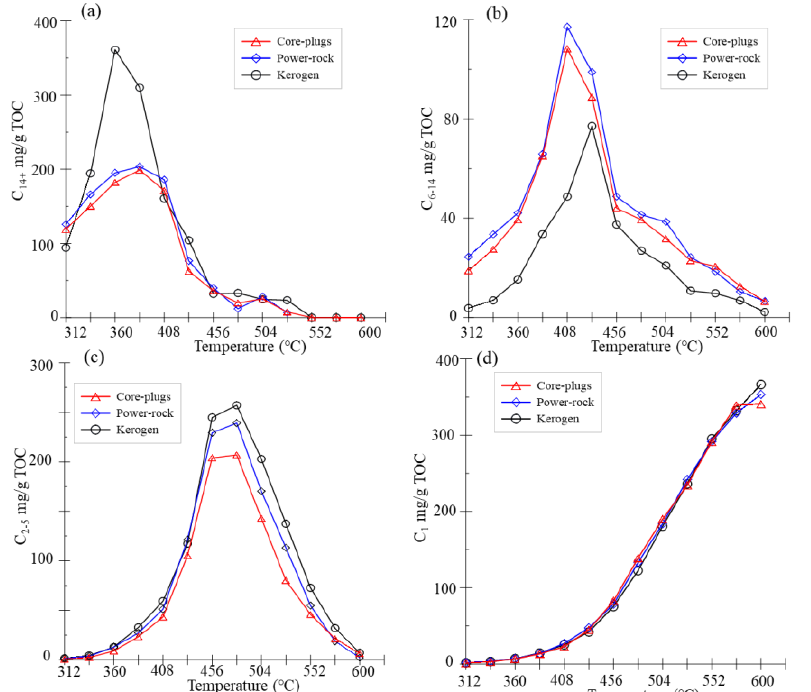
Figure 4. Hydrocarbon yield generated from pyrolysis of core plugs, powdered rock and kerogen of Maoming oil shale. ( a ) Heavy hydrocarbons (C 14+ ); ( b ) light hydrocarbons (C 6-14 ); ( c ) wet gas (∑C 2- 5 ); ( d ) methane (C 1 ).